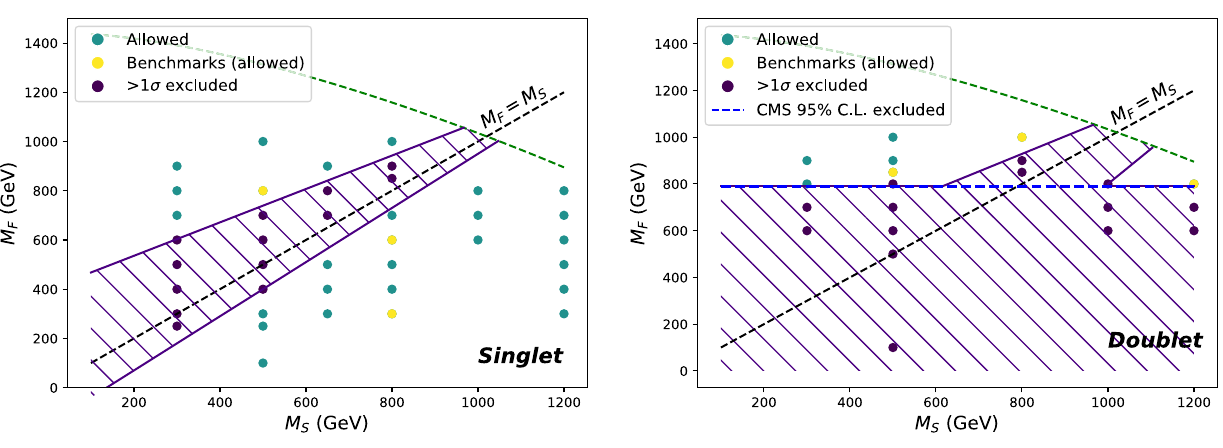
Fig. 6 Allowed(greenandyellowpoints)andexcluded(purplepoints) values of the VLL mass M F and the BSM scalar mass M S with κ (cid:4) fixed (7). For the points marked as allowed, all bins in the sum of transverse momenta L T of the 4L final sates fall within 1 σ of central values mea-